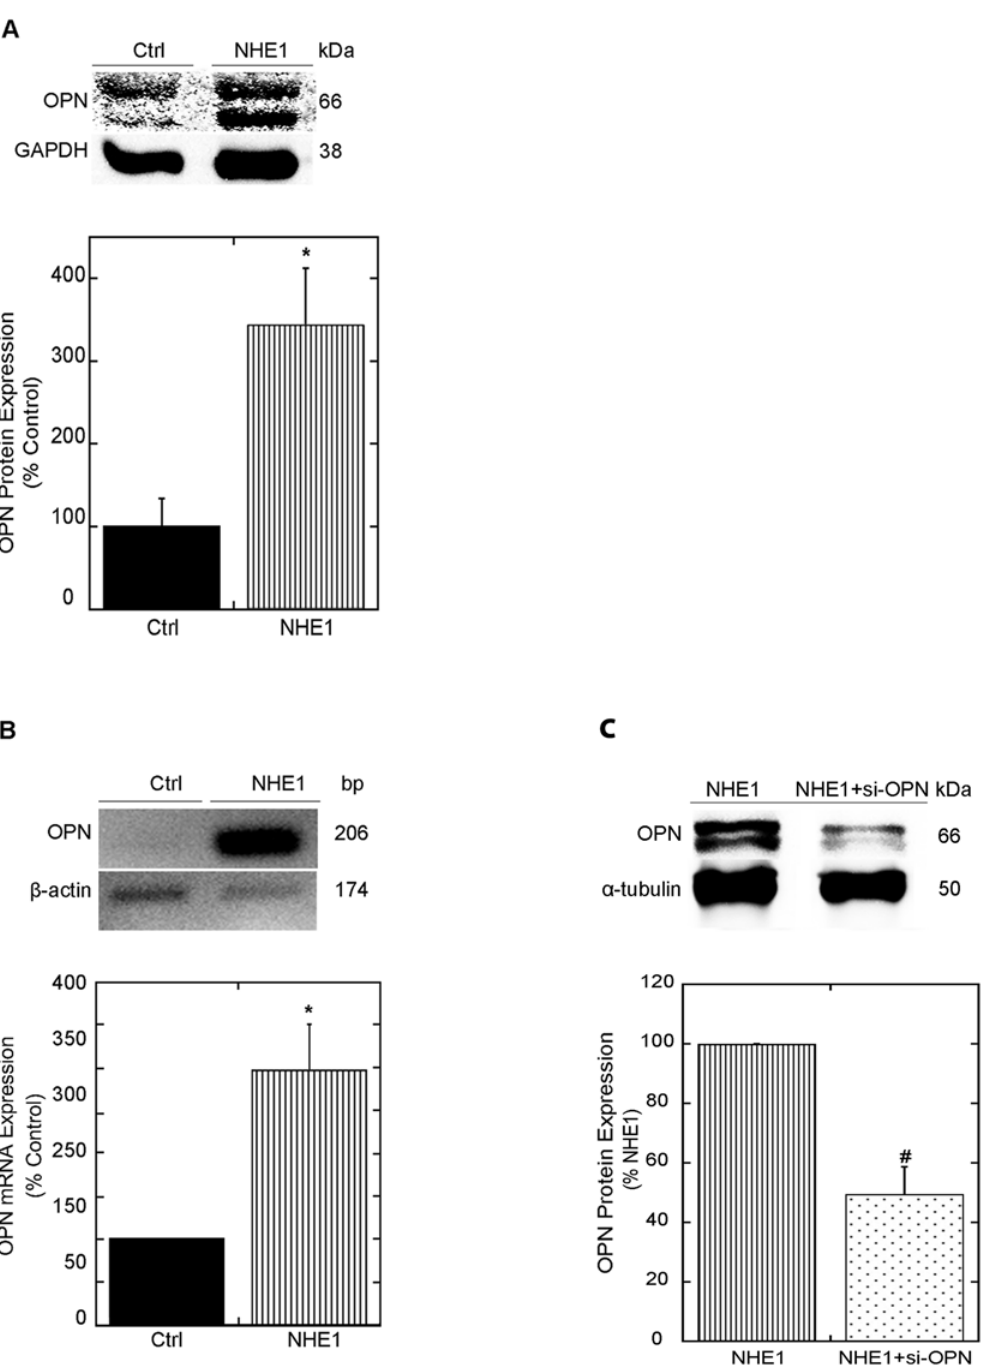
Fig 1. Upregulation of NHE1 in cardiomyocytes enhances OPN expression. A: Upper panel, representative western blot of OPN protein expression in cell lysates of NRVMs infected with GFP (control) or active NHE1 adenovirus for 24 hours. Immunoblotting was against OPN (doublet at 66 kDa) and GAPDH (38 kDa). Lower level, quantification of relative levels of total OPN protein expression (n = 4; representative of 2 – 3 preparations). B: Upper panel, representative DNA gel of OPN mRNA expression in H9c2 cardiomyocytes infected with GFP (control) or active NHE1 adenovirus for 24 hours using an MOI of 20 and 30, respectively. cDNA amplification was against OPN (206 bp) and β -actin (174 bp). Lower level, quantification of OPN mRNA expression in H9c2 cardiomyocytes normalized to β -actin (n = 6 – 7; representative of 4 experiments). Results expressed as % of control (GFP) ± %SEM. * p < 0 . 05 vs. control. C: Upper panel, representative western blot of OPN protein expression of H9c2 cardiomyocytes infected with NHE1 adenovirus (30 MOI) in the presence and absence of 100nM siRNA OPN for 24 hours. Immunoblotting was against OPN (doublet at 66 kDa) and α -tubulin (50 kDa); lower panel, quantification of relative levels of OPN protein expression (n = 6 – 9; representative of 2 – 3 experiments). Results are expressed as % of NHE1 ± %SEM. * p < 0 . 05 vs. NHE1 + siRNA.